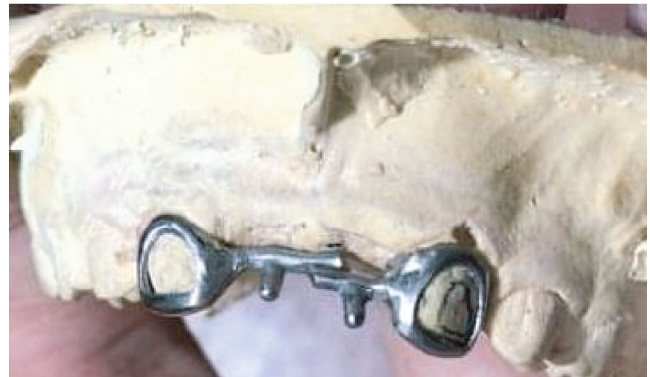
Figure 1: Design of a bar-tube system of the Denari prosthesis.